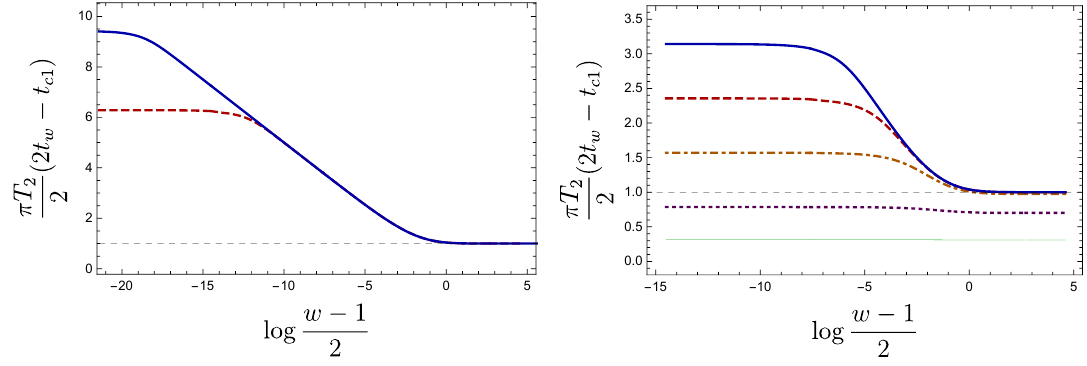
w (cid:0) 1 Figure 4. Dependence of the critical time t = log( (cid:15)= 2), which parametrizes the c 1 on log 2 energy in the shock wave. In the left panel, we show the behaviour of t c 1 for early shock waves: T 2 t w = 3 in solid blue, and T 2 t w = 2 in dashed red. In this case, we see the transition between the light shock behaviour (3.64) and the heavy shock behavior (3.61). In the right panel, we show the behaviour of t c 1 when the shock wave is not sent very early, i.e., with T 2 t w = 0 : 1 ; 0 : 25 ; 0 : 5 ; 0 : 75 ; 1 from bottom to top. For these parameters, the range of w that has approximately a log dependence starts appearing as the shock wave is sent earlier (larger t w ). The horizontal thin dashed black line is just 1 (for both